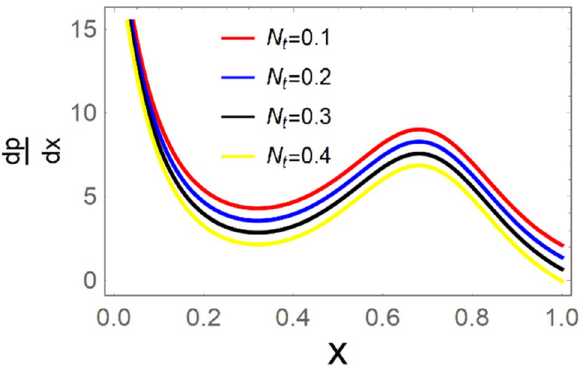
d p d x profile for N t